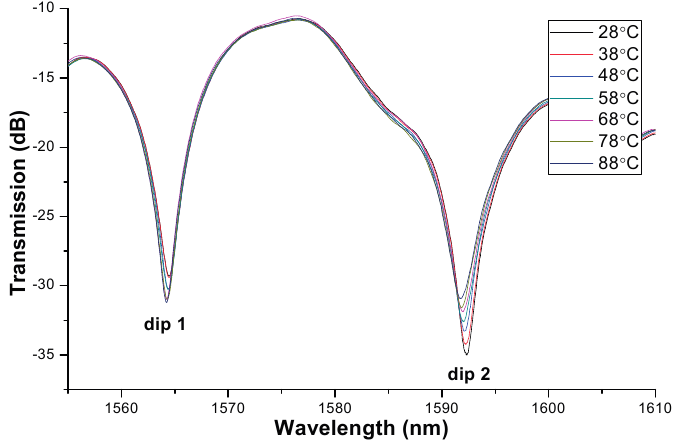
Figure 7. Transmission spectra of the proposed sensing structure at different temperatures.